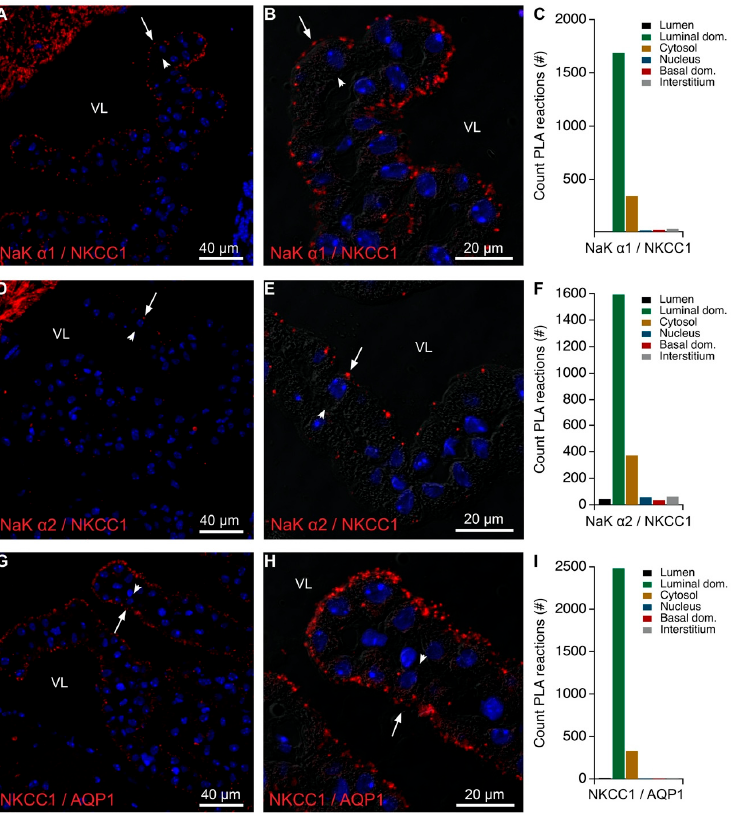
Figure 6. Colocalization of NKCC1 and Na,K-ATPase and AQP1 subunits by PLA. ( A ) Representative immunofluores- cence image of PLA products (red) using anti-Na,K-ATPase α 1 (NaK α 1) and anti-NKCC1 antibodies and cell nucleus counterstain (blue) at low magnification. ( B ) Higher magnification micrograph of the same structure overlaid on the cor- responding DIC image. ( C ) Bar graph representing the count of PLA reactions in the indicated image areas. ( D ) Repre- sentative immunofluorescence image of PLA products (red) using anti-Na,K-ATPase α 2 (NaK α 2) and anti-NKCC1 anti- bodies and cell nucleus counterstain (blue) at low magnification. ( E ) Higher magnification micrograph of the same struc- ture overlaid on the corresponding DIC image. ( F ) Bar graph representing the count of PLA reactions in the indicated image areas. ( G ) Representative immunofluorescence image of PLA products (red) using anti-NKCC1 and anti-AQP1 antibodies and cell nucleus counterstain (blue) at low magnification. ( H ) Higher magnification micrograph of the same structure overlaid on the corresponding DIC image. ( I ) Bar graph representing the count of PLA reactions in the indicated image areas. Arrows indicate luminal surfaces, while arrowheads mark basolateral surfaces. VL denotes the fourth ven- tricle lumen.